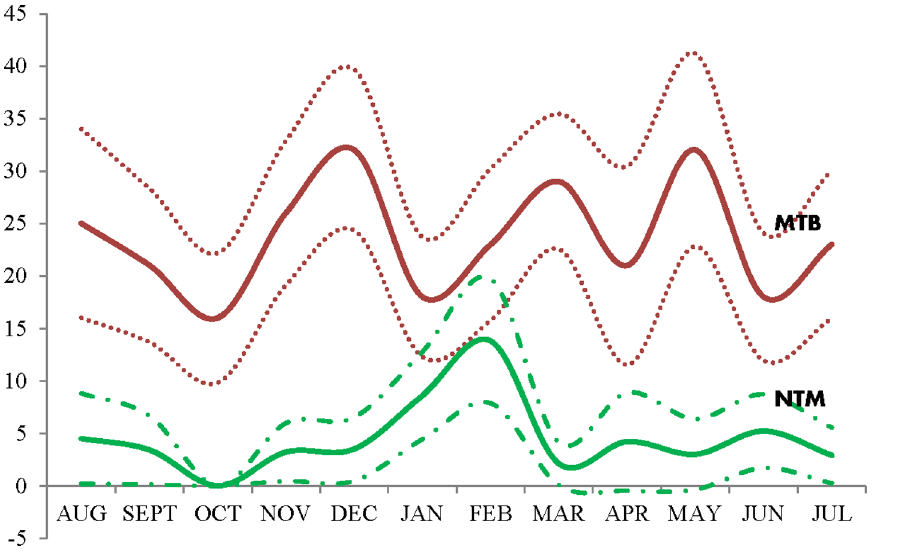
Figure 2. Pattern of occurrence of tuberculosis and non-tuberculous mycobacterial infections over 12 calendar months in Nigeria. Y-axis: monthly proportions of NTM and MTB complex among all subjects screened (solid lines indicate proportion while dotted lines are the 95% confidence interval of the proportion) X-axis: time in months.